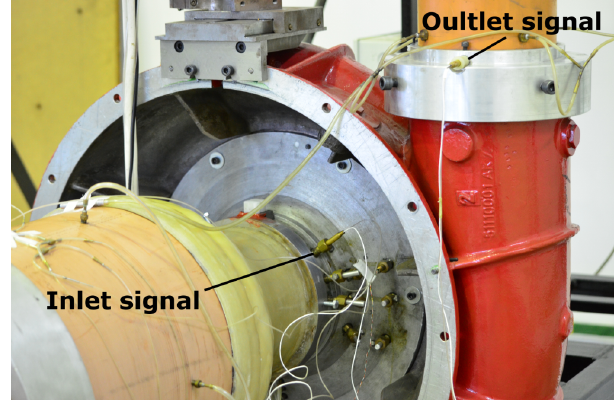
Figure 2: Experimental rig used in this study